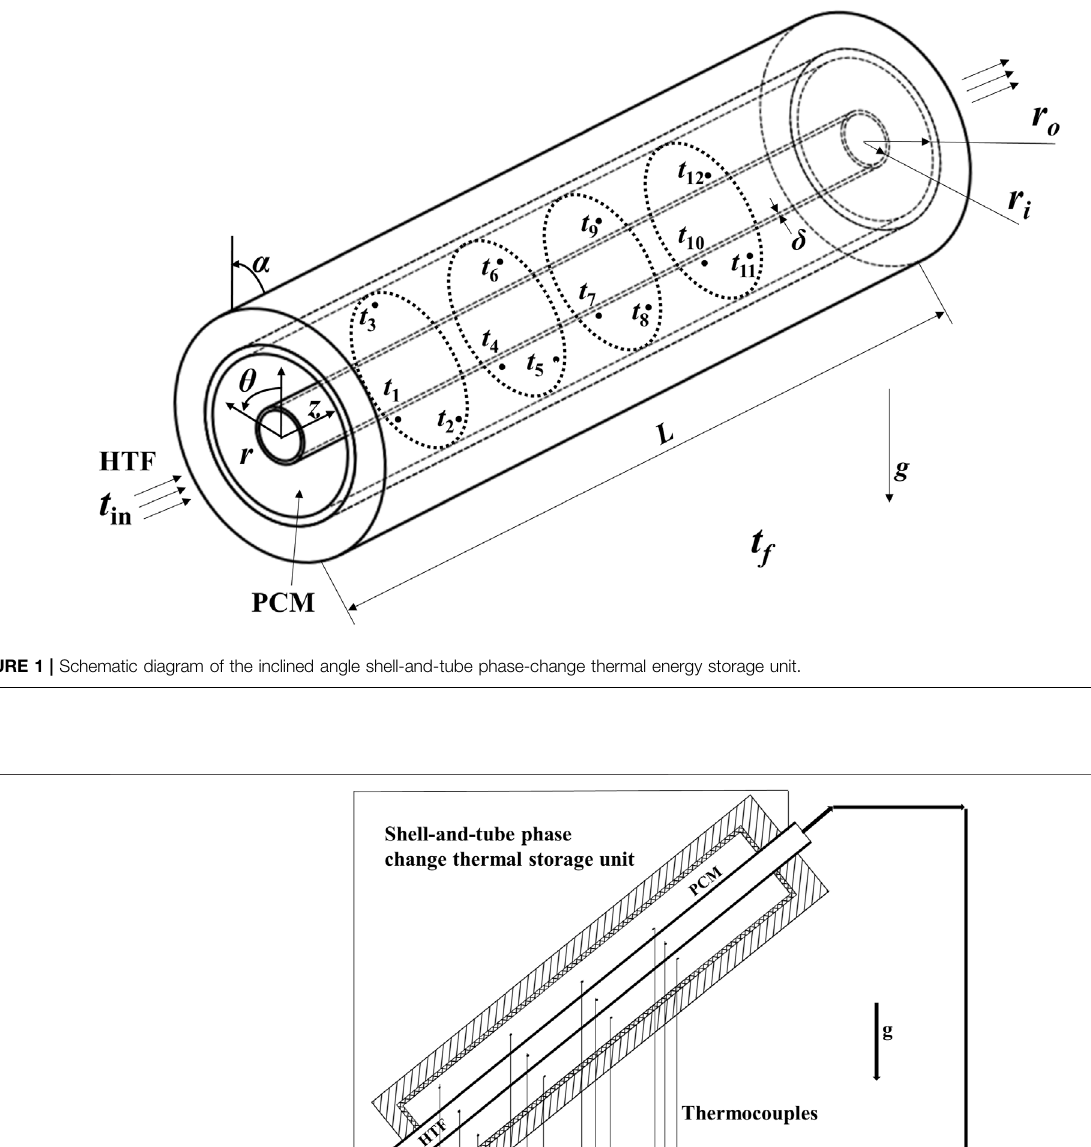
storage unit. The effects of inlet temperature and HTF fl ow rate on the heat storage rate of the inclined heat storage unit will be investigated in detail.